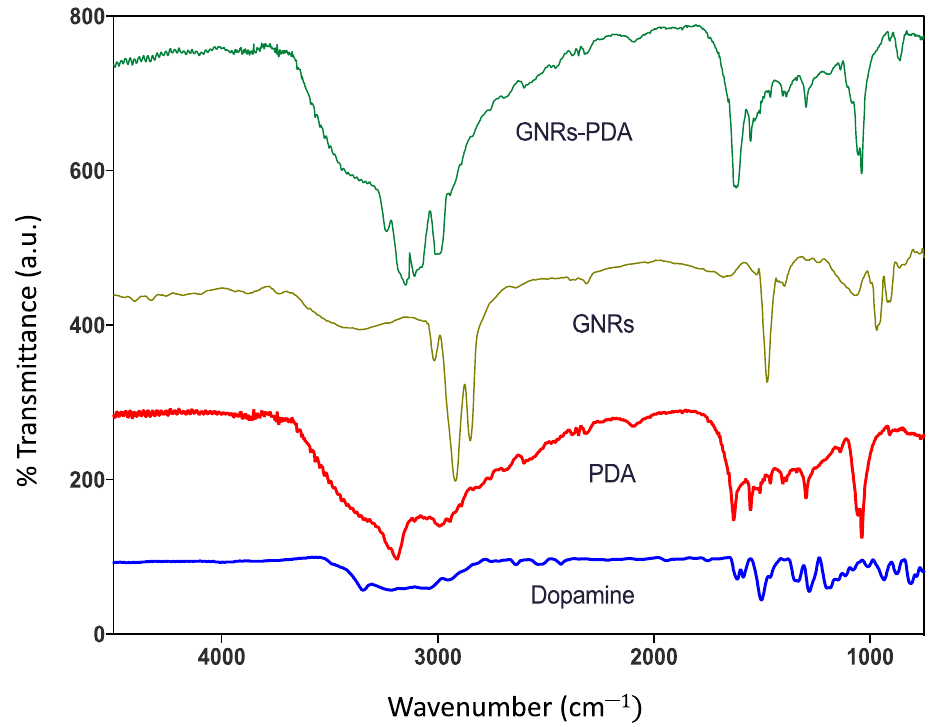
Figure 2. FTIR spectra of dopamine, polydopamine (PDA), GNRs and polydopamine-conjugated GNRs.